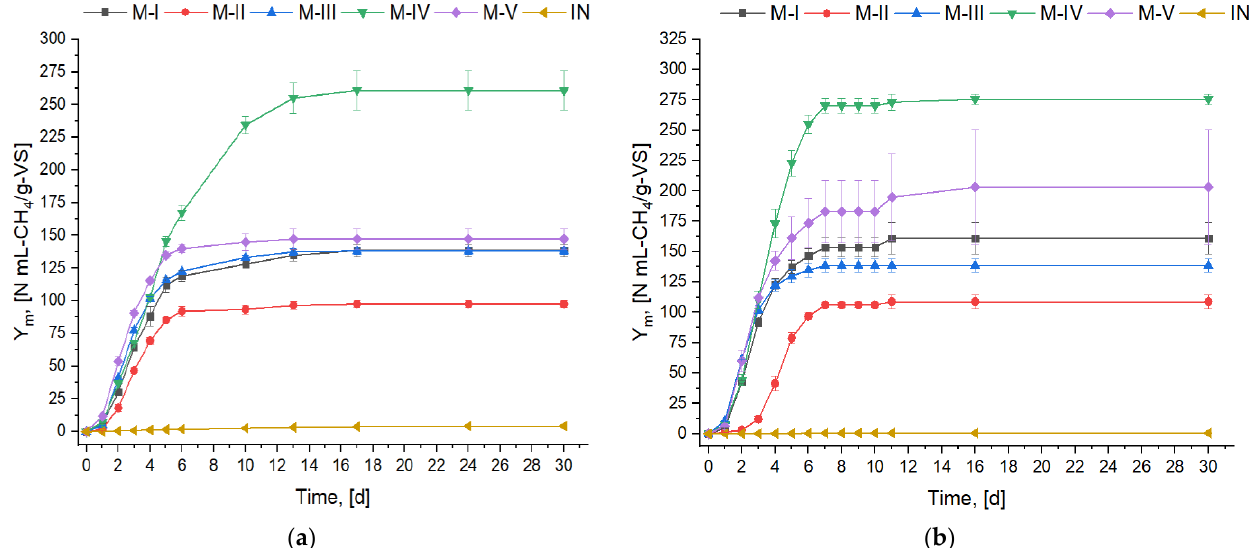
Figure 5. Cumulative specific methane yield: ( a ) mesophilic temperature; ( b ) thermophilic temperature.